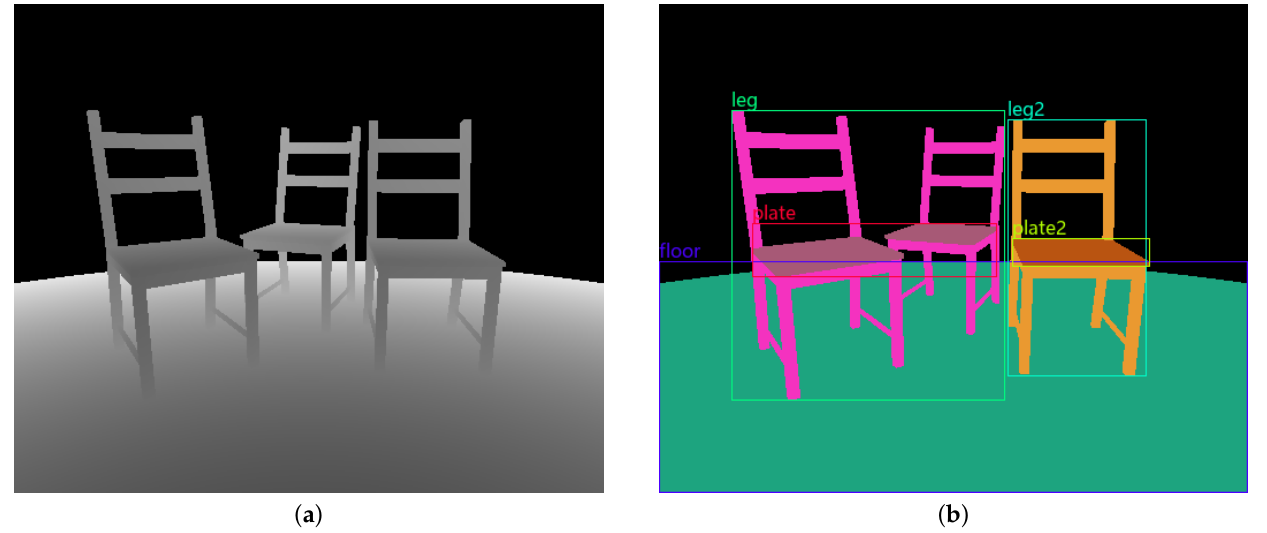
Figure 12. ( a ) Depth image of the example scene where pixel colors correspond to distance measurements. ( b ) Pixel-wise semantic segmentation of the image. The left and middle chair components share the same semantic category and are therefore colored